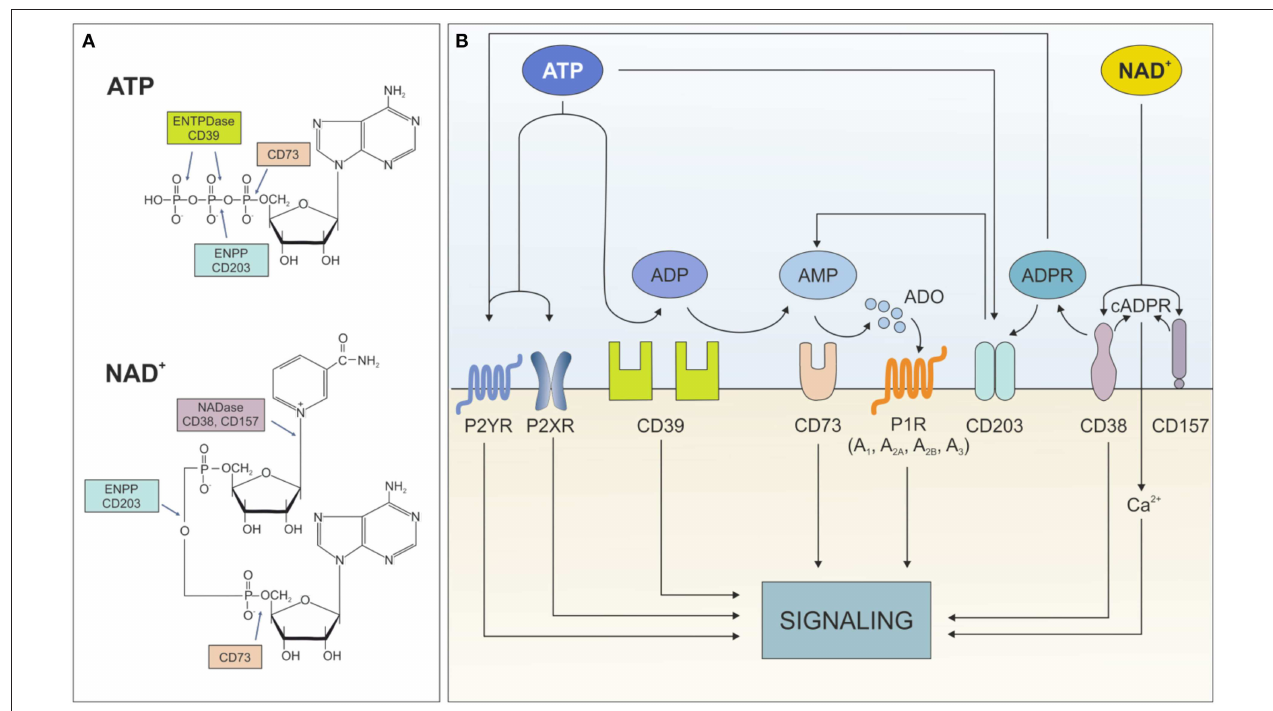
FIGURE 1 | Ectonucleotidases network. (A) Structure of ATP and NAD + with indication of cleavage sites by the different ectonucleotidases. (B) Schematic representation of the fate of extracellular ATP and NAD + dismantling operated by the different ectonucleotidases and the functional consequences of the generated metabolites. ENTPDase, ecto-nucleoside triphosphate diphosphohydrolase; ENPP, ecto-phosphodiesterase/nucleotide phosphohydrolase; ATP, adenine-triphosphate; ADP, adenine-diphosphate; AMP, adenine-monophosphate; ADO, adenosine; P2XR, ATP-gated P2X receptor cation channel; P2YR,